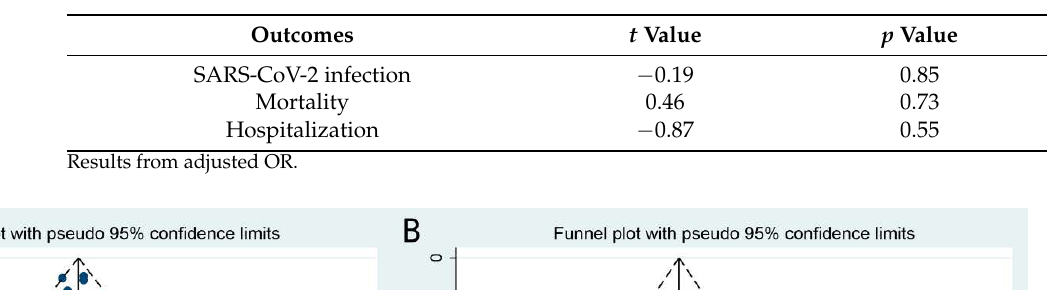
Table 5. Summary of publication bias on the association between influenza vaccination and SARS- CoV-2 infection and clinical outcomes.